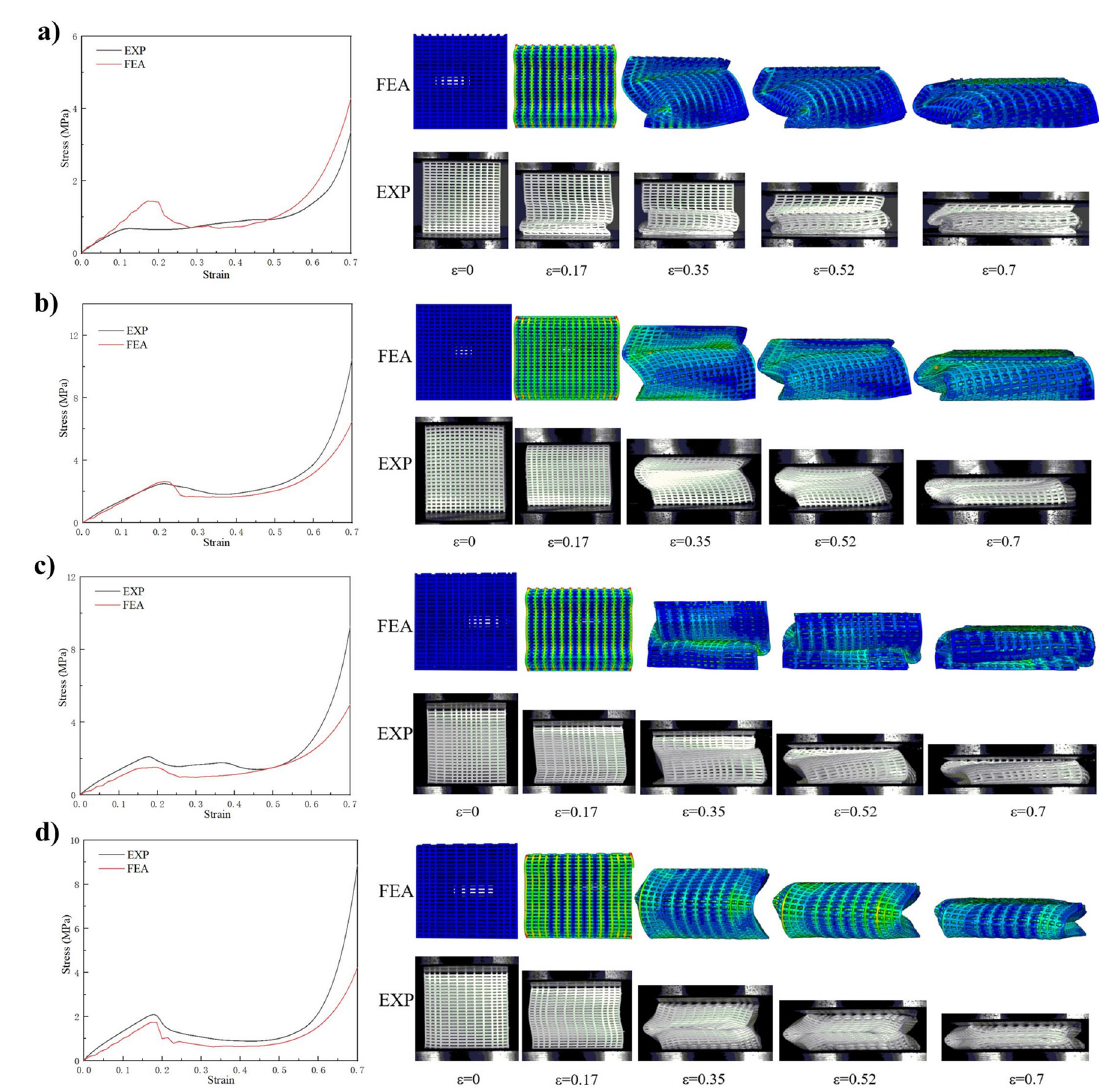
Figure 5. Comparison of experiment and simulation stress-strain curves and deformation mode: a) L-1, b) L-2, c) L-4, d) L-5.